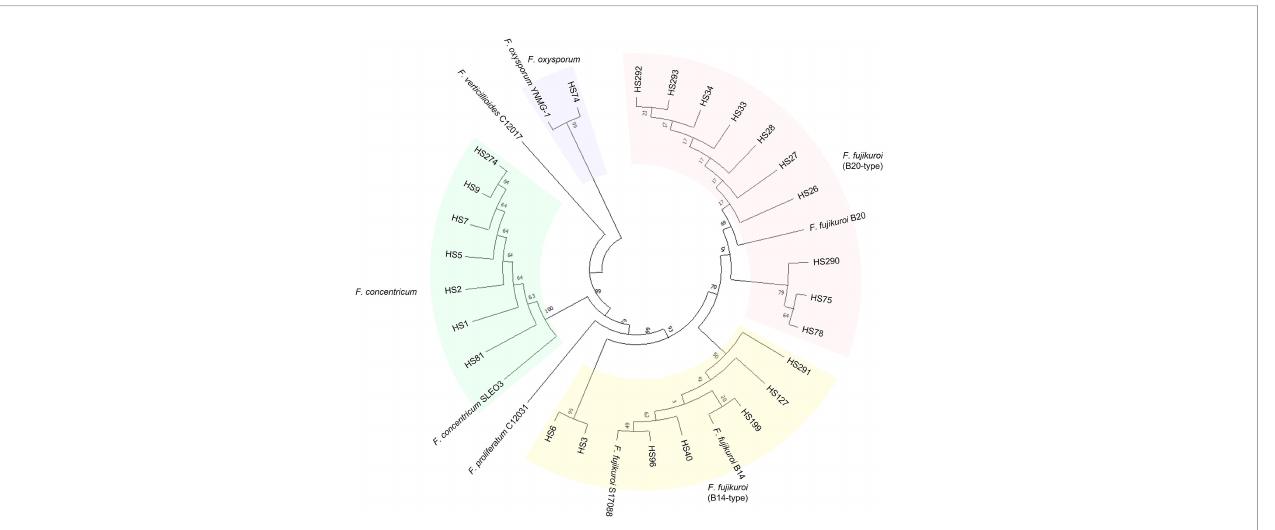
FIGURE 3 A phylogenetic tree of the FFSC strains inferred from the TEF-1 a gene sequence. In the phylogenetic tree, F. concentricum , F. verticillioides , F. proliferatum , and two types of F. fujikuroi strains belong to FFSC. The F. fujikuroi strains are distinguished into two groups: B14-type and B20-type. Two strains of F. fujikuroi , B14 and B20, known as FB producer and non-producer, respectively, were used as references. TEF-1 a gene sequences of four FFSC strains (C12017, C12031, S17088, and SLEO3) and the F. oxysporum strain (YNMG-1) were obtained from GenBank. Strains of the same color indicate they are in the same phylogenetic group.